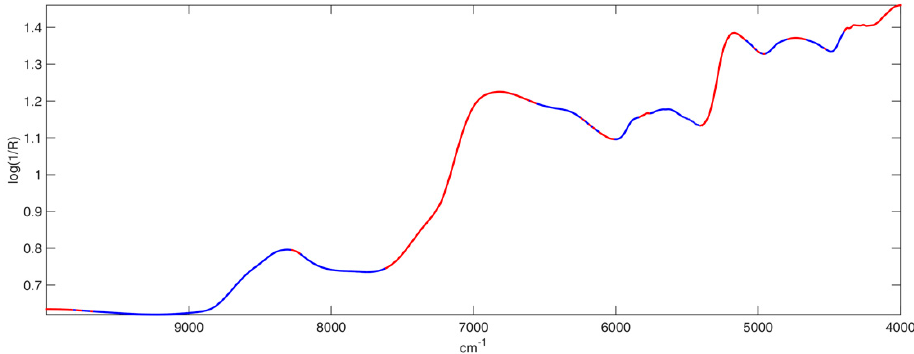
Figure 3. Variable Importance in Projection (VIP) analysis. Averaged spectrum (blue line). Selected variables are bolded in red.